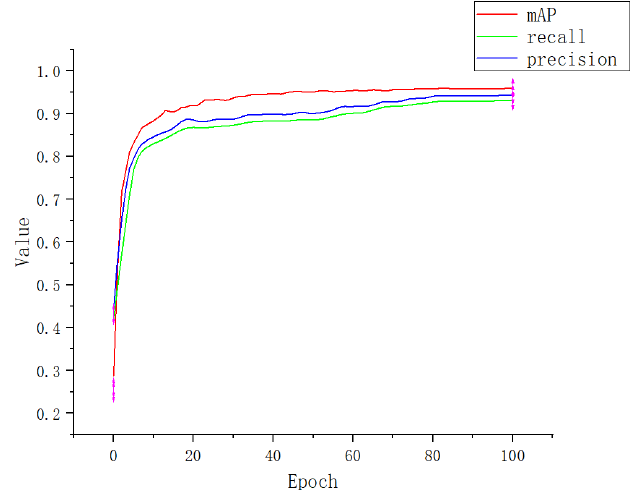
Figure 15. Performance index curve of CA.